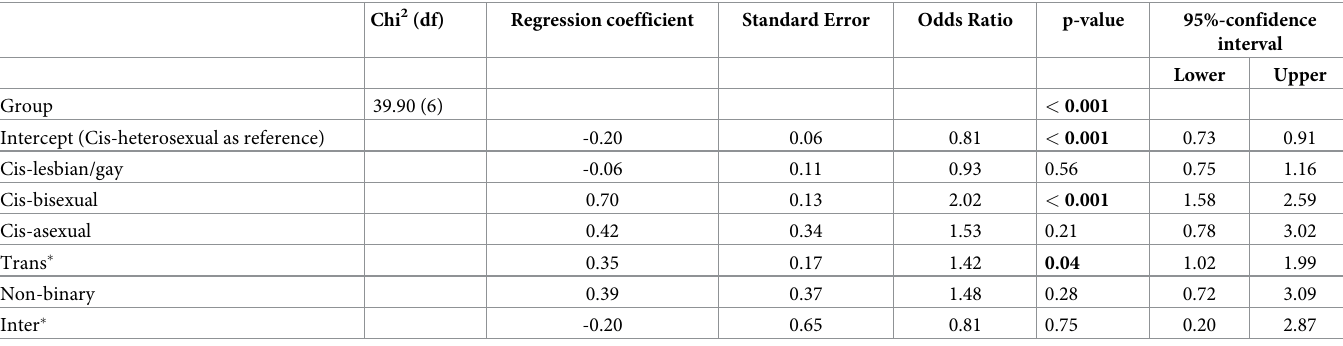
Table 3. Logistic regression of self-assigned sexual and gender identities on clinically significant depression as dependent variable measured with WHO-5 1 . Chi 2